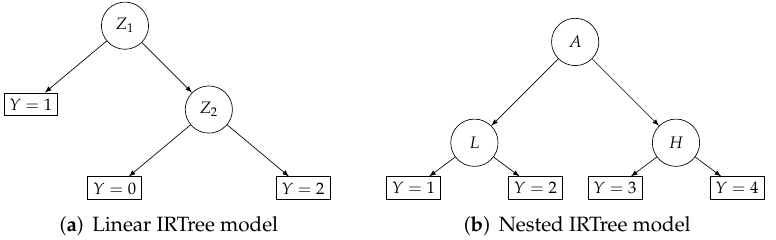
Figure 2. Example of IRTree of a rating scale with three (e.g., 0: Disagree; 1: Neutral; 2: Agree) or four